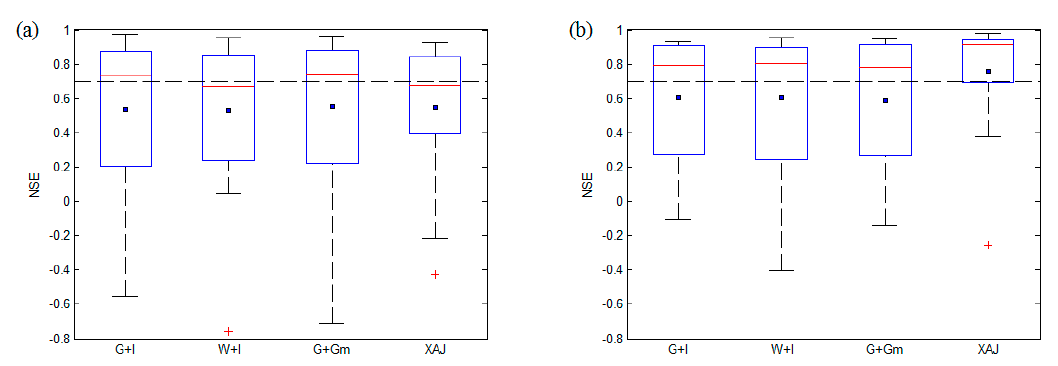
Figure 12. Comparison of the NSE-values of four scenarios, G + I, W + I, G + Gm and XAJ, in the rising limb ( a ) and falling limb ( b ). The meanings of red line and plus are identical to Figure 5 and blue square is the average. The values of black dotted lines in ( a ) and ( b ) are both 0.7.